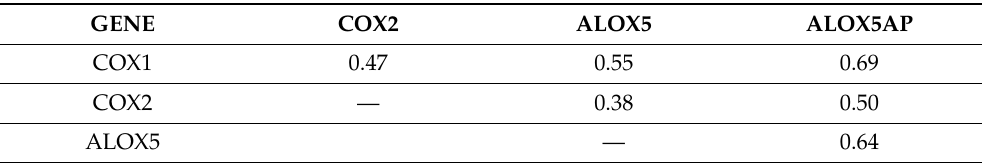
Table 1. Pearson correlation coefficients for COX1, COX2, ALOX5 and ALOX5AP among 411 speci-